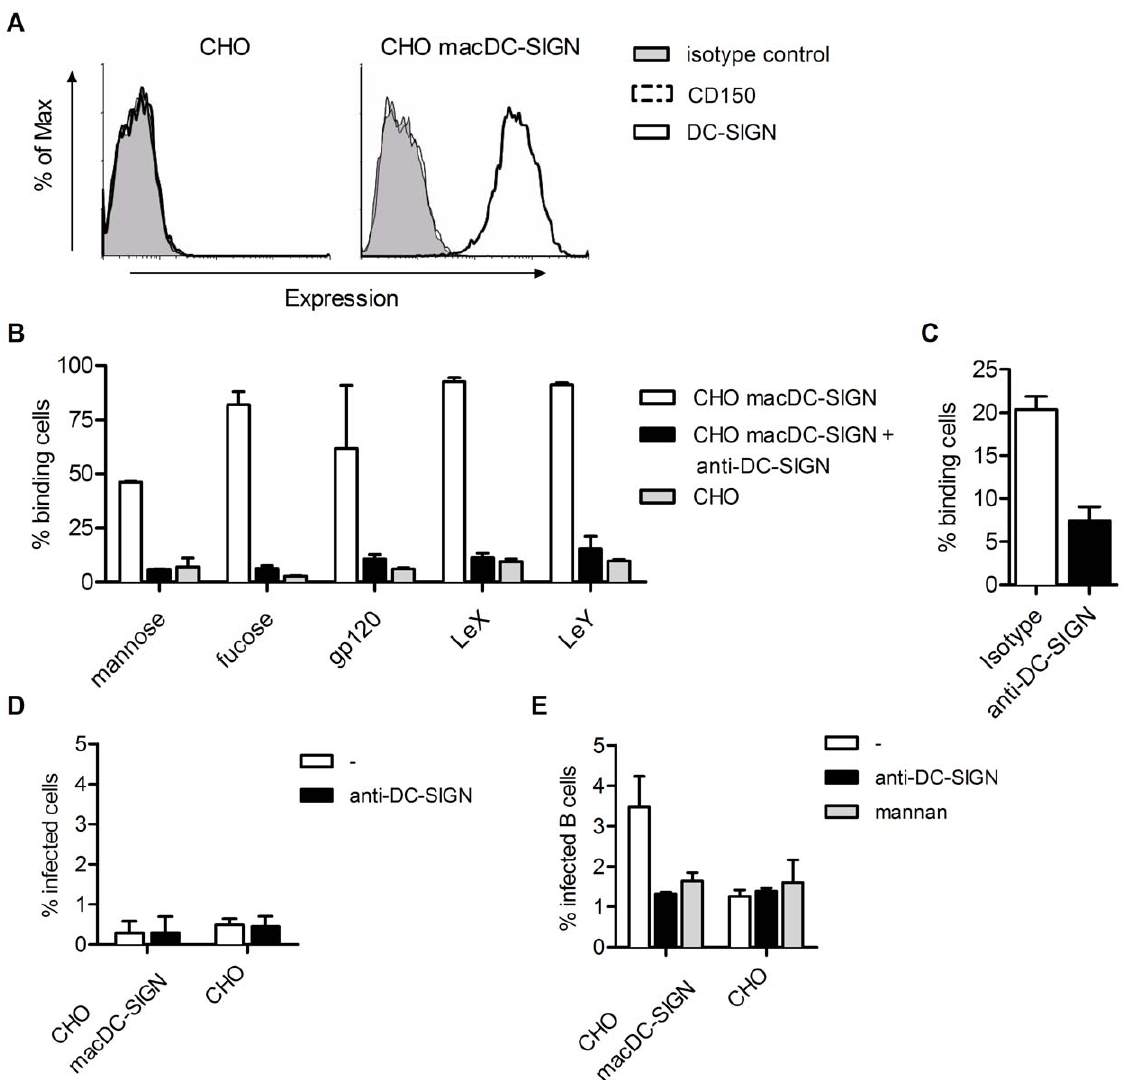
Figure 4. Macaque DC-SIGN binds mannose structures including MV and transmits MV to CD150 + target cells. (A) CHO cells were transfected with macDC-SIGN. The mean expression levels of DC-SIGN and CD150 of the parental cell line and transfectants are depicted. Gray areas represent isotype controls. (B) MacDC-SIGN binds mannose and fucose structures on fluorescent beads. Binding was blocked by anti-DC-SIGN (20 ug/ ml. (C) CHO transfectants were pre-incubated with anti-DC-SIGN antibodies or isotype control (20 ug/ml) before incubation with FITC-labeled UV- inactivated MV. Binding was measured by flow cytometry. (D) Parental and transfected CHO cells were infected with rMV KS EGFP (MOI 1) and 48 hours post infection EGFP levels were measured in FACS. (E) Cells were incubated with rMV KS EGFP (MOI 3). After 3 hours cells were washed and CD150 + Raji cells were added to the culture. Infection of Raji cells was determined by measuring EGFP in flow cytometry. Transmission was blocked by pre- incubating CHO macDC-SIGN cells with anti-DC-SIGN (20 ug/ml) or mannan (0.25 mg/ml). All data are representatives for at least 2 independent experiments. Error bars represent standard deviations of duplicates.